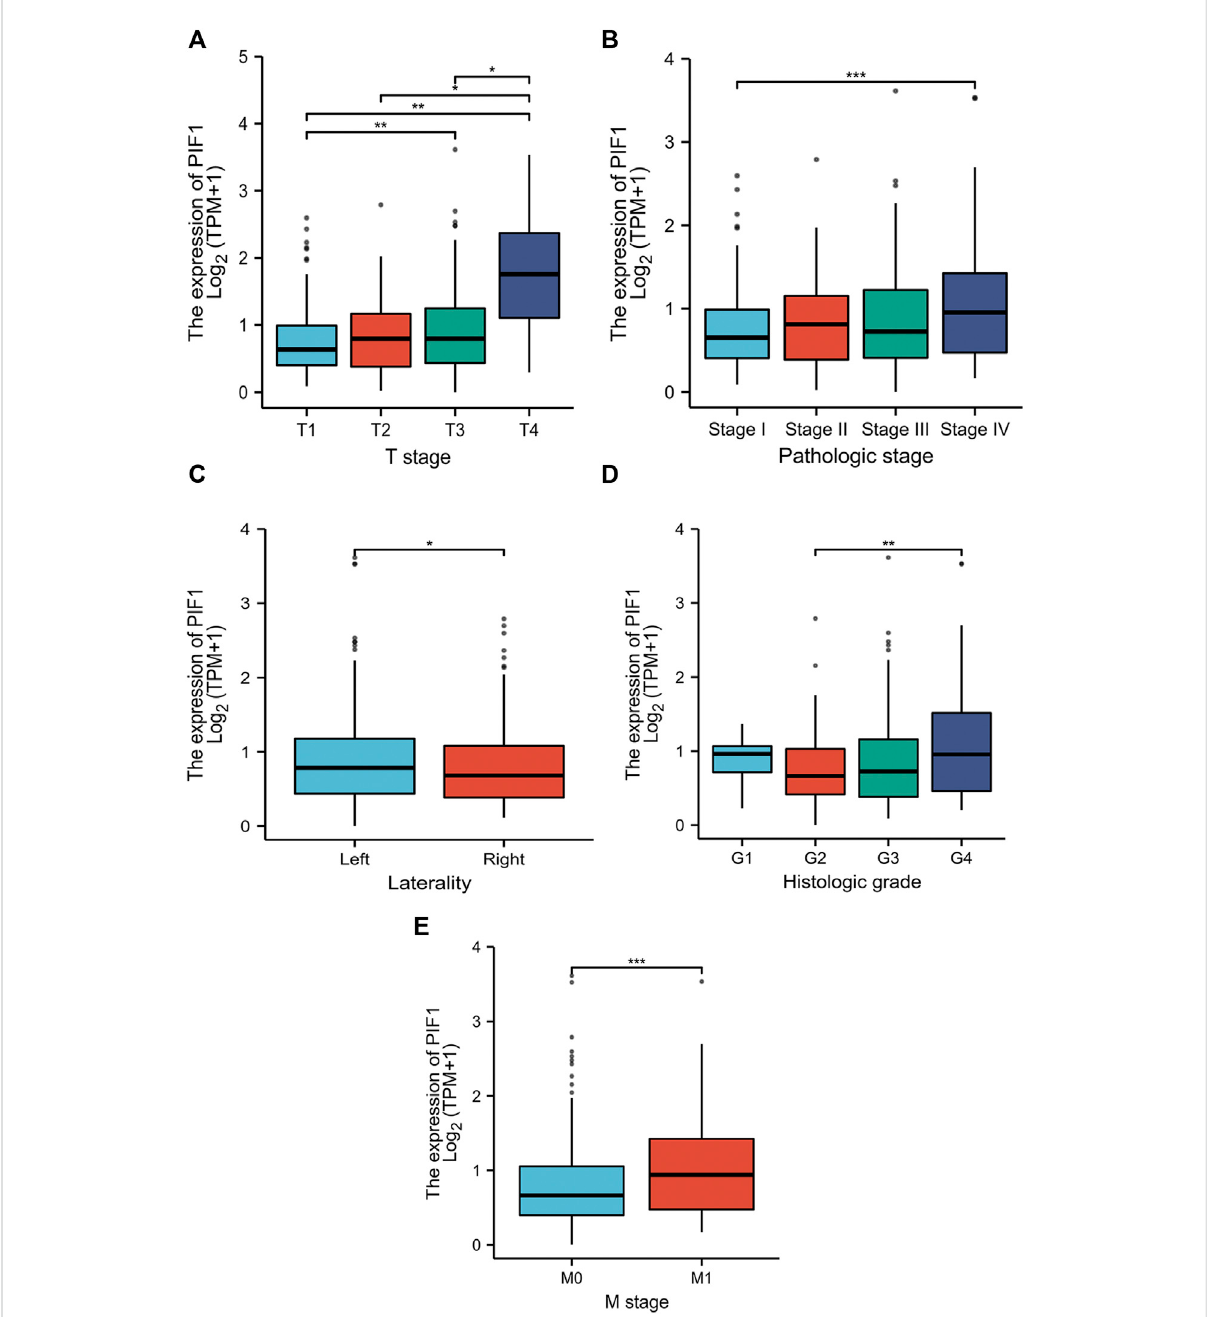
FIGURE 3 Relationships between PIF1 mRNA levels and clinical pathological characteristics. Higher expression levels of PIF1 were observed in patients withhighTstage (A) ,patientswithhighpathologicstage (B) ,patientswithleftccRCC (C) ,patientswithhistologicgrade (D) ,andpatientswithMstage (E) . (ns, no signi fi cance, * p < 0.05, ** p < 0.01, *** p <